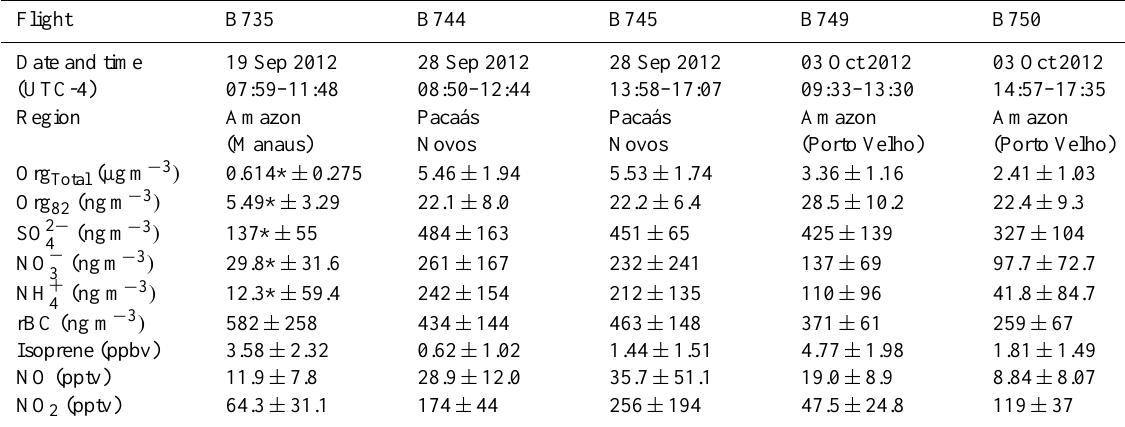
Table 1. Composition statistics for the data taken below 2km for the five flights, with standard deviations, shown to 3 significant digits. Time periods refer to AMS data coverage. All mass concentrations are reported at standard temperature and pressure (273.15K, 1013hPa). Quantities denoted by * were impacted by an inlet blockage and failed quantification quality checks.